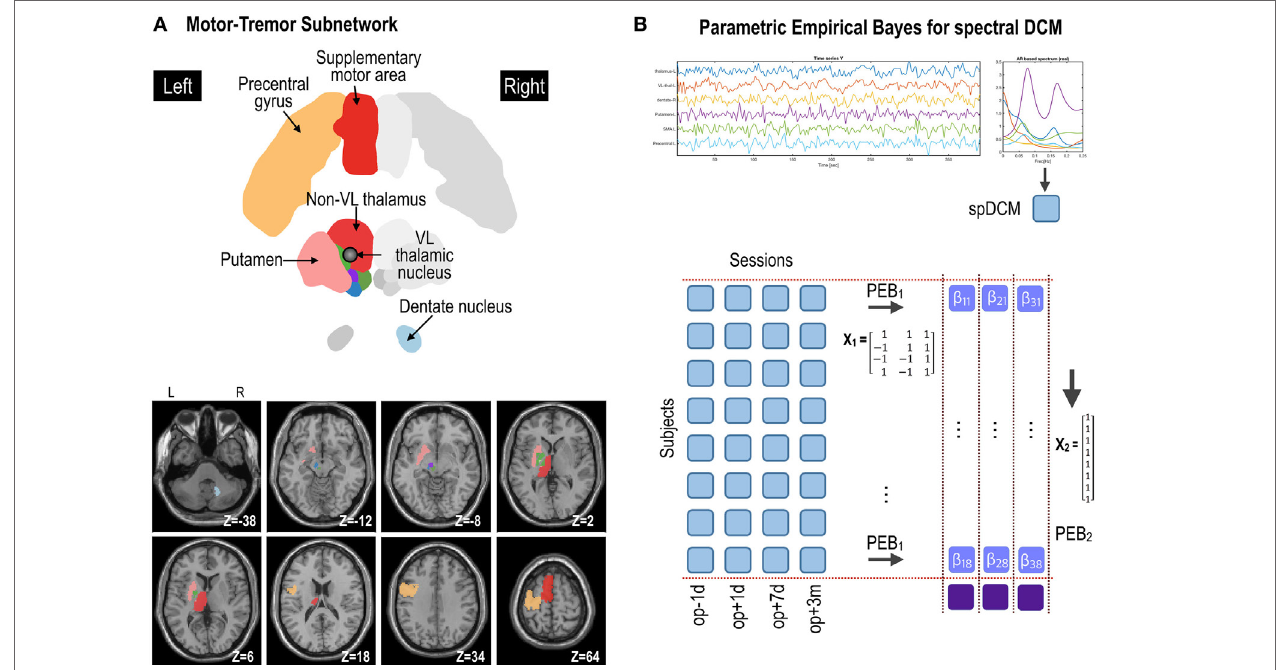
FIgURe 2 | Procedures for parametric empirical Bays (PEB) effective connectivity analysis of the motor subnetwork (A) . Spectral dynamic causal modeling (spDCM) was applied to each patient’s resting-state fMRI data at four time points: op − 1d, op + 1d, op + 7d, and op + 3m (1 day before operation, 1 day after operation, 7 days after operation, and 3 months after operation, respectively) (B) . The motor subnetwork includes the precentral gyrus, supplementary motor areas, putamen, ventrolateral (VL) thalamic nucleus, and non-VL thalamic nuclei in the left hemisphere, and right dentate nucleus in the cerebellum. The coordinate in panel (A) (e.g., Z = − 38) is the Montreal Neurological Institute template space. L and R indicate left and right. For the group-level analysis, PEB analysis was applied at two levels; (1) PEB 1 across four sessions with a regressor of a transient effect ([1 − 1 − 1 1]), a regressor of a sustained treatment effect ([1 1 − 1 − 1]), and a baseline ([1 1 1 1]); (2) PEB 2 across (eight) patients with a regressor of [1 1 1 1 1 1 1 1] T to model group effects across